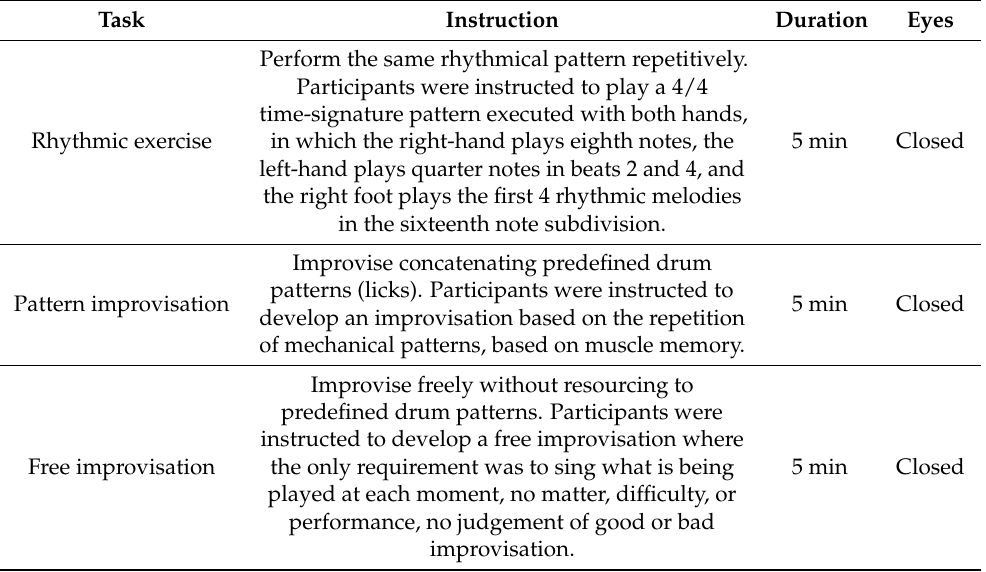
Table 2. Tasks performed by